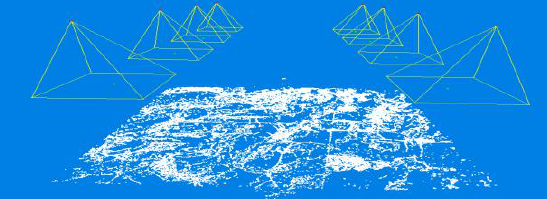
Figure 9. Situation in an AAP (left) and a detail